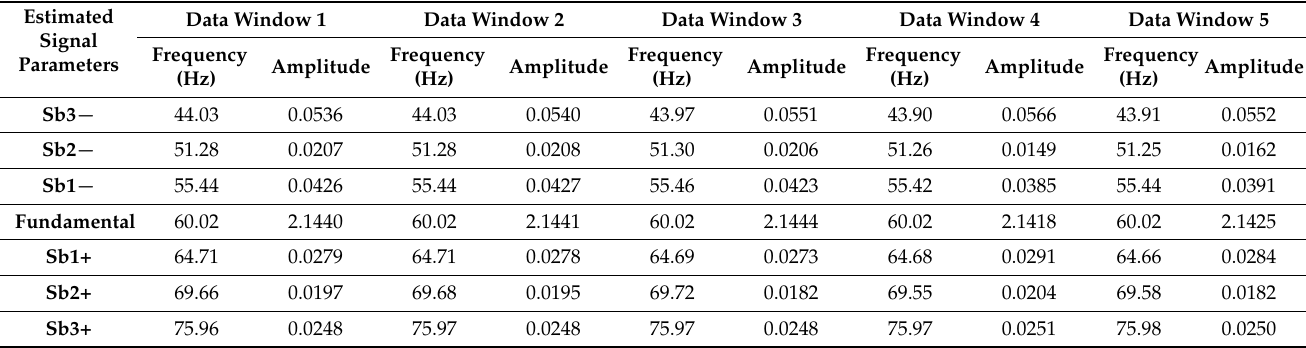
Table 6. Measured current signal estimated parameters.